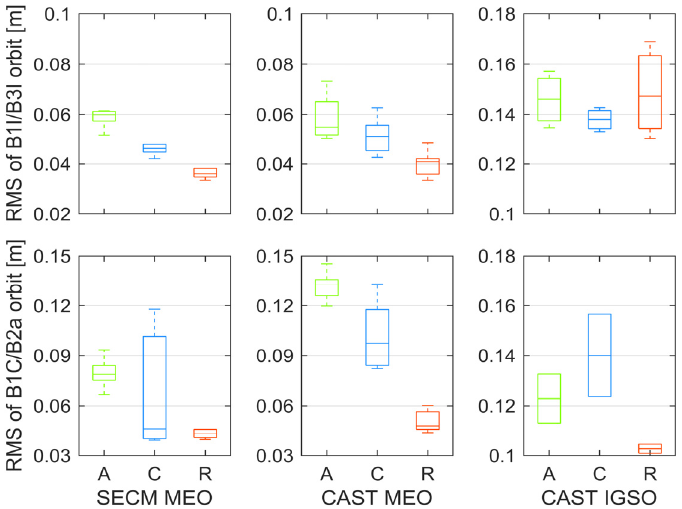
Figure 11. Box plot of RMSs of ISU orbits based on B1I/B3I and B1C/B2a in along-track, cross-track, and radial directions for SECM MEO, CAST MEO, and CAST IGSO satellites, respectively.